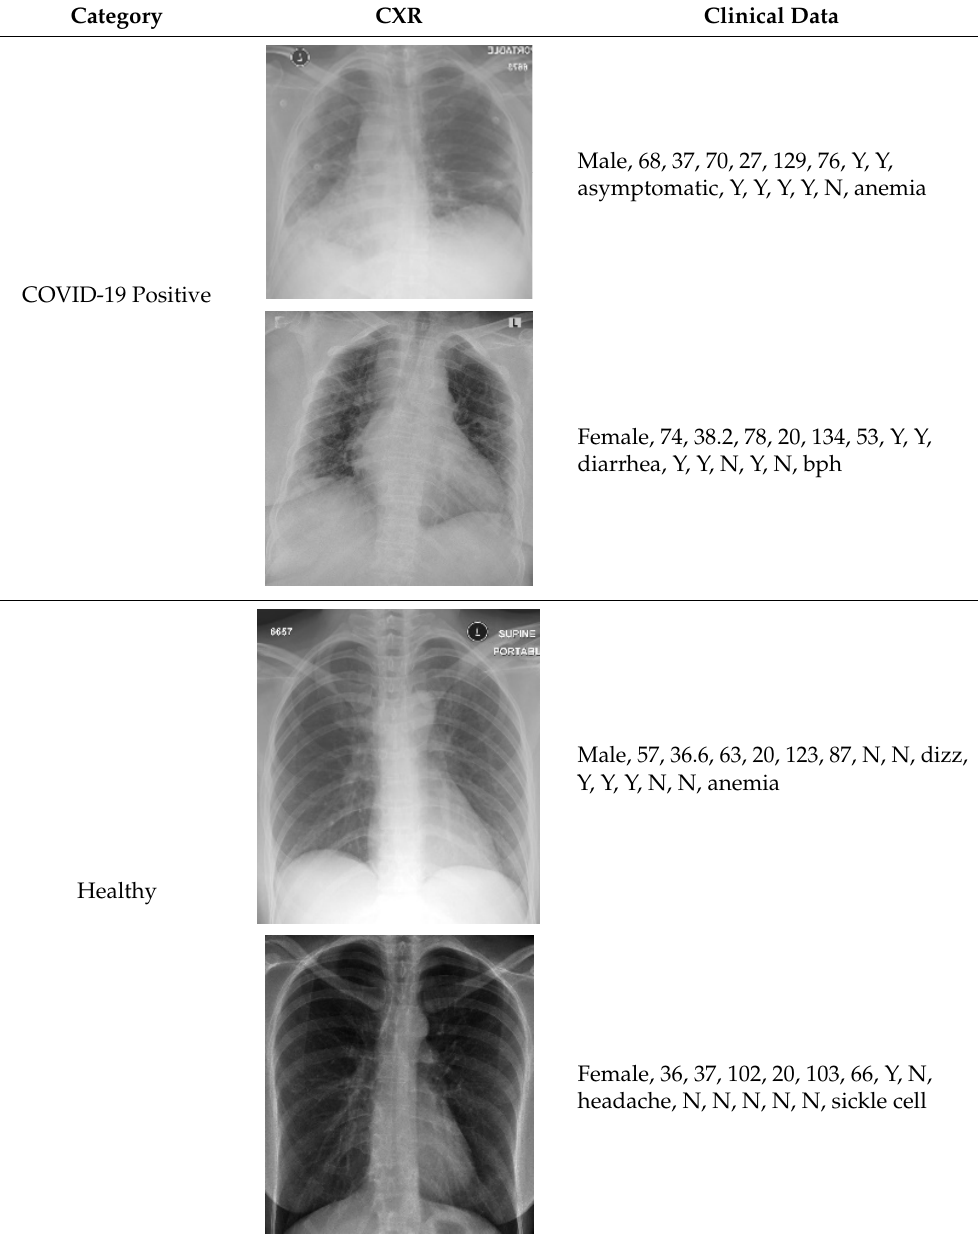
Table 5. Sample CXR and clinical data for the COVID-19 positive and healthy cases.